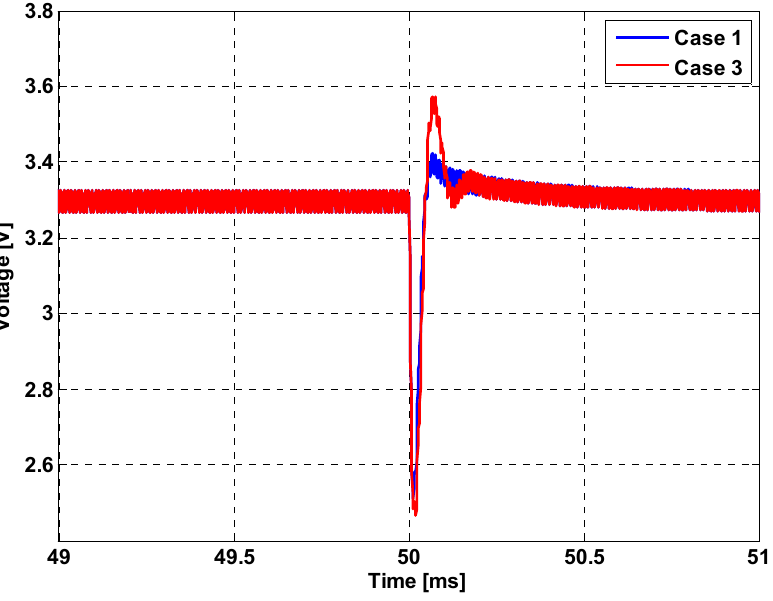
Figure 9. Load regulation performance comparison.